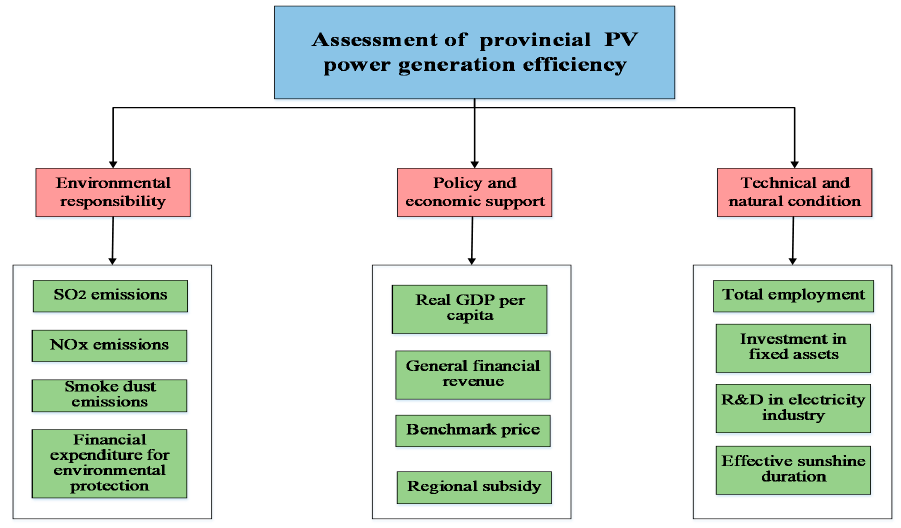
Figure 3. Hierarchical assessment index system of PV power generation efficiency.